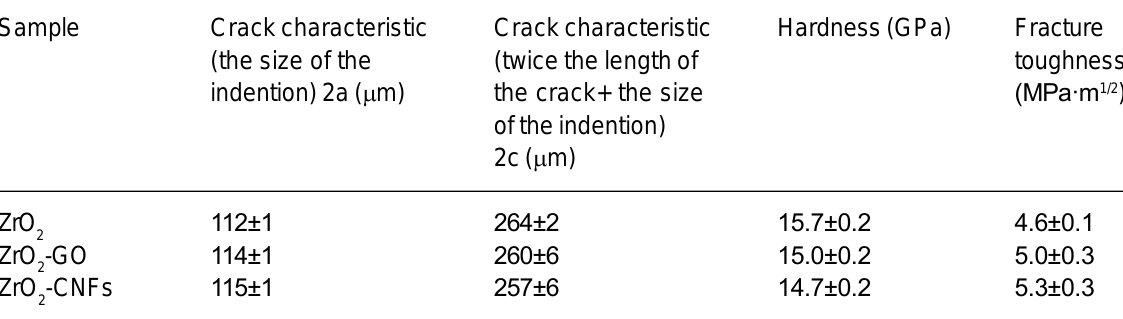
Table 3. Mechanical properties and crack characteristics for ZrO additive, data from [86].